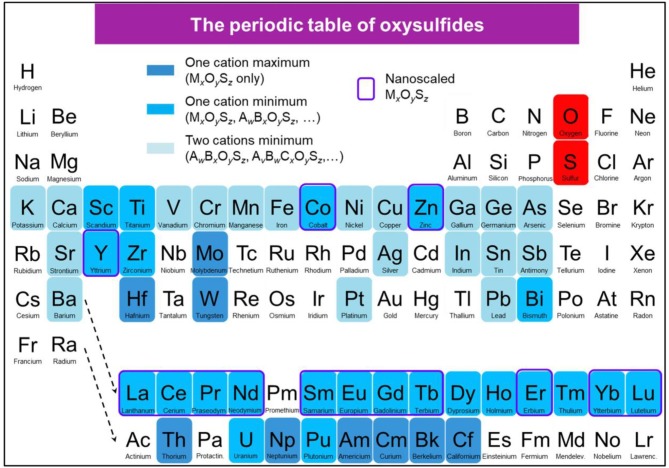
Periodic table showing the reported oxysulfide compounds. In blue are indicated the elements that can be found in synthetic or natural oxysulfides. Blue shades indicate the compositions (ternary, quaternary, and more) that can be achieved for each element. Surrounded in violet are the elements for which MxOySz nanoparticles were reported.